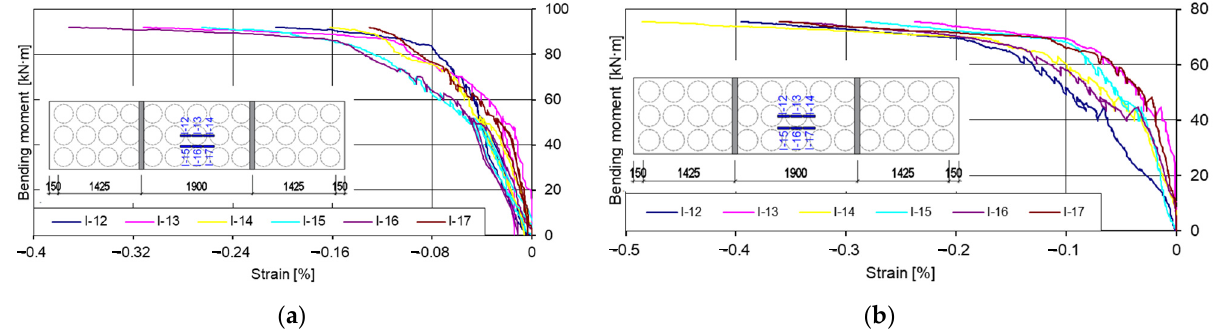
Figure 25. Graphs of bending moments: strains in the compressive zone of the slabs. ( a ) First slab (I pl); ( b ) second slab (II pl).